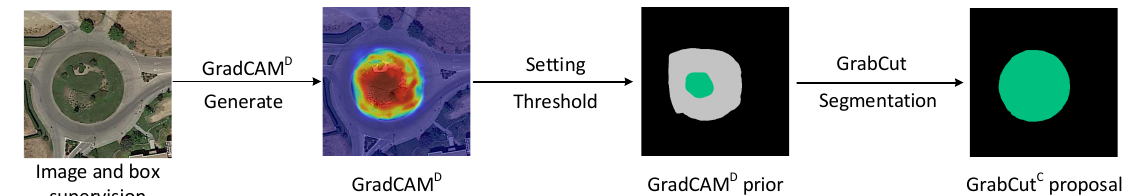
Figure 5. Visualization of the GradCAM D . It shows why the detector classifies a specific area as a specific class and covers instance region well.